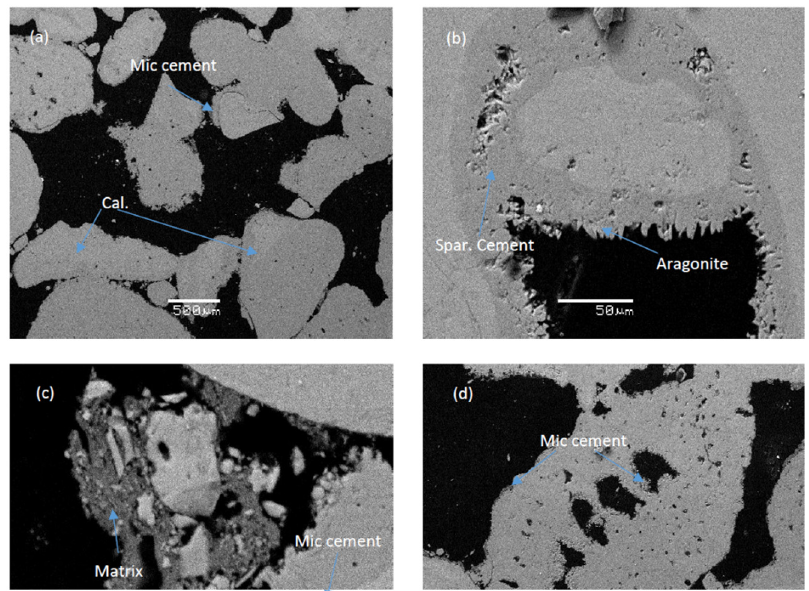
Figure 4. SEM images of sample Sum1: ( a ) well-crystalized calcite and aragonite needles are coating calcite grains and microfossils that are consolidated; ( b ) sparitic cement and aragonite are precipi- tated inside a microfossil; ( c ) micritic cement with the matrix consisting of very fine sedimentary particles; ( d ) micritic cement that is coating a microfossil and is precipitated inside its vents.